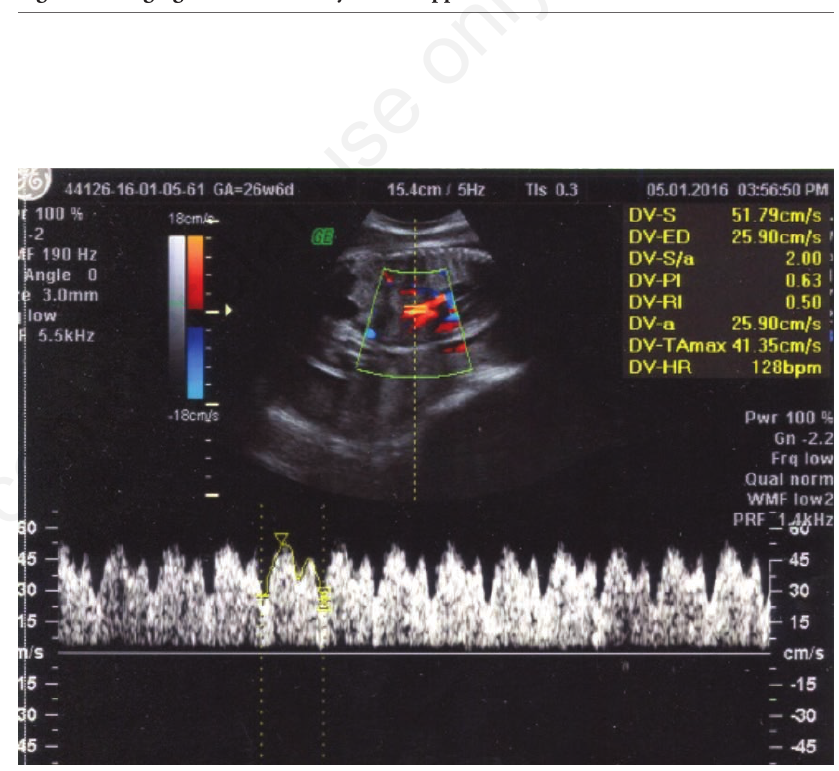
Figure 2. Imaging of normal DV doppler measurement.